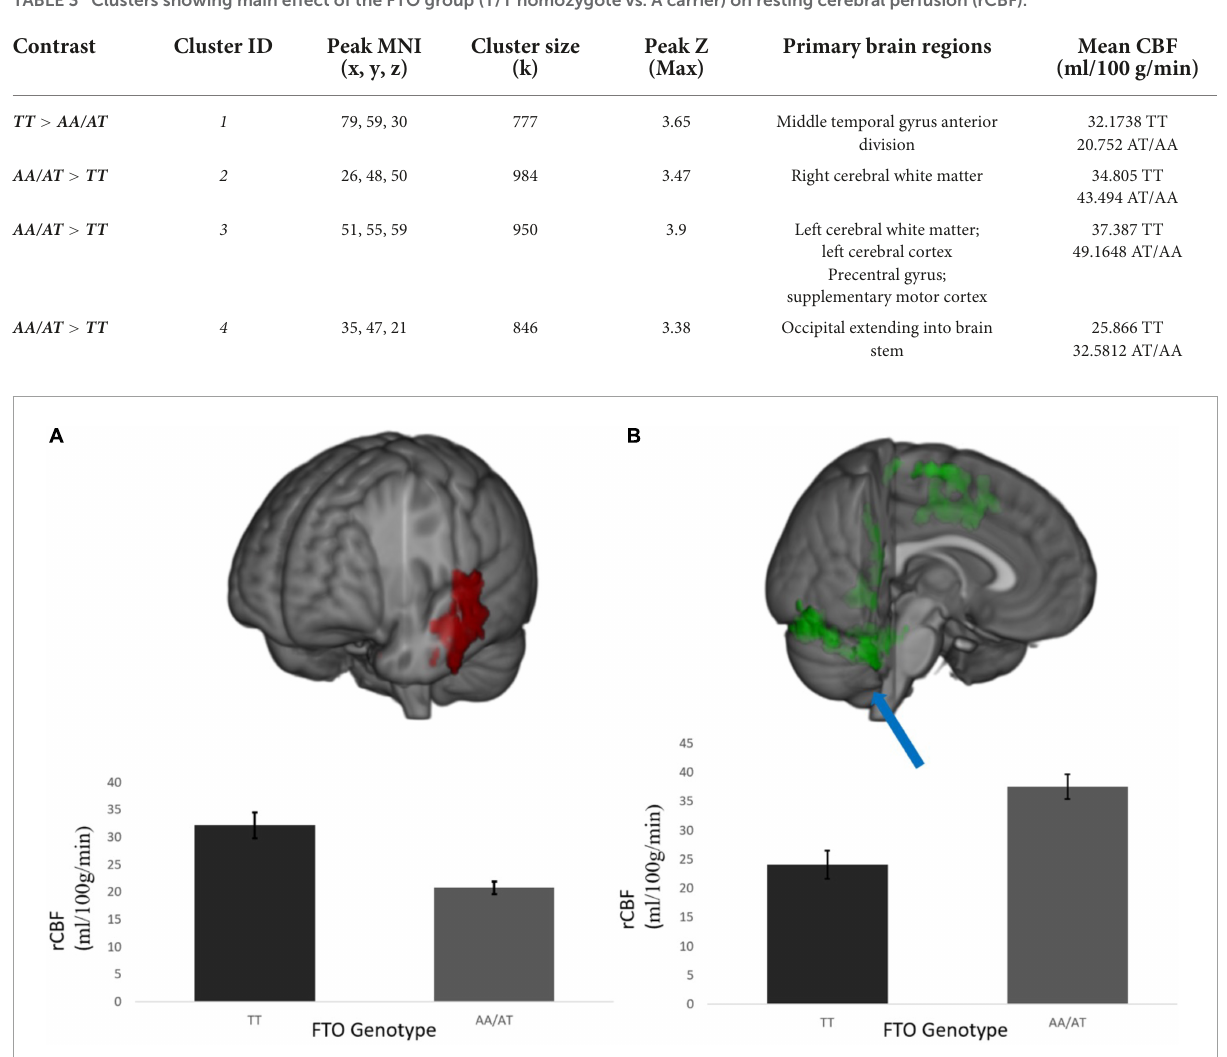
FIGURE2 (A) Temporal cluster where rCBF for A carriers < T/T homozygotes and (B) representative cluster in the posterior occipital cortex where rCBF for A carriers > T/T homozygotes; This was a diffuse cluster had peak coordinates in the occipital lobe, extending into cerebellum, brain stem, and motor cortex. rCBF values are measured in ml/100 g/min. Results were corrected for multiple comparisons and was estimated that contiguous clusters ≥ 293 voxels and z -values > 2.3 survived a threshold of p <